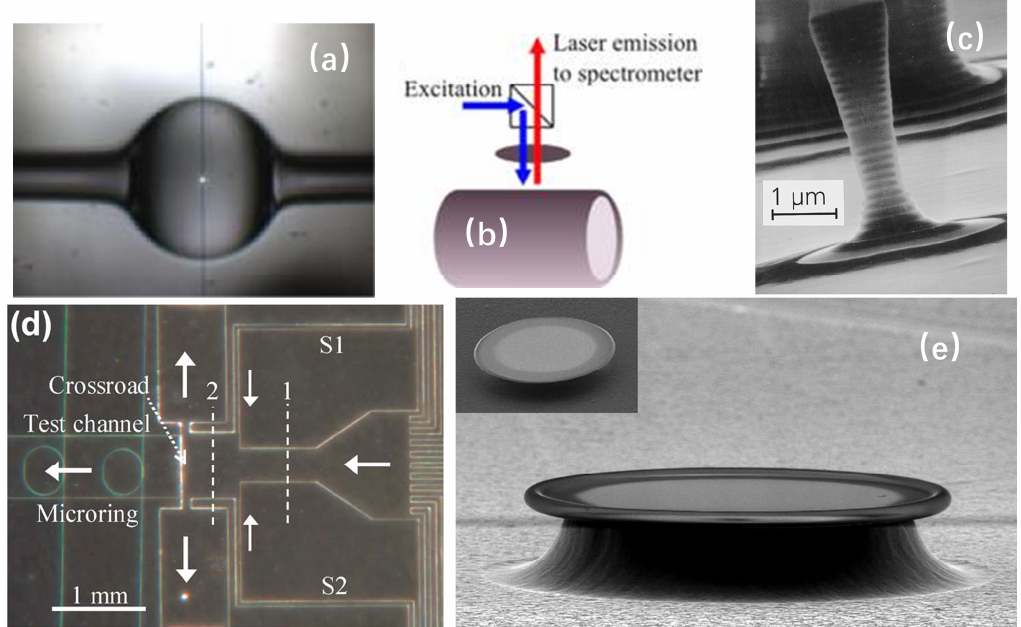
Figure 2. Several forms of whispering-gallery microcavities: ( a ) droplet type [28]; ( b ) capillary type [29]; ( c ) microcolumn type [30]; ( d ) micro- ring type [31]; and ( e ) micro-disk type [32].